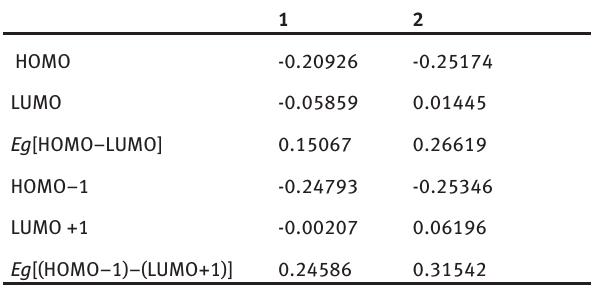
Table 8: The calculated HOMO-LUMO energy (a.u.) and HOMO-LUMO band gap Eg values for 1 - 2 using DFT method at B3LYP/ 6-31G( d ) level.